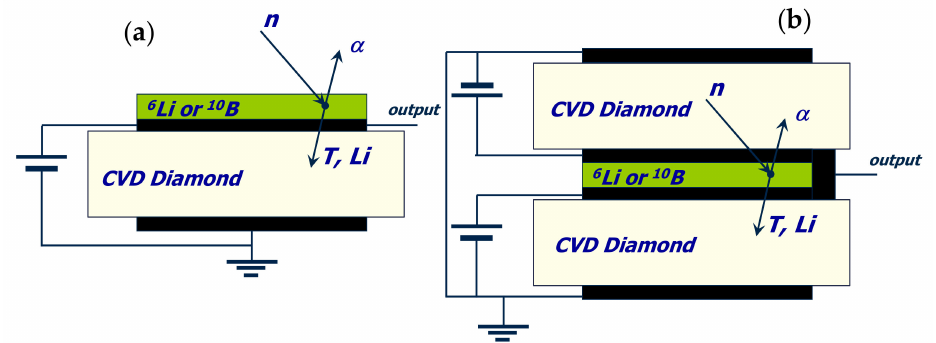
Figure 17. ( a ) Lay-out of a diamond detector covered with a 6 Li or 10 B converting layer and ( b ) in “sandwich”